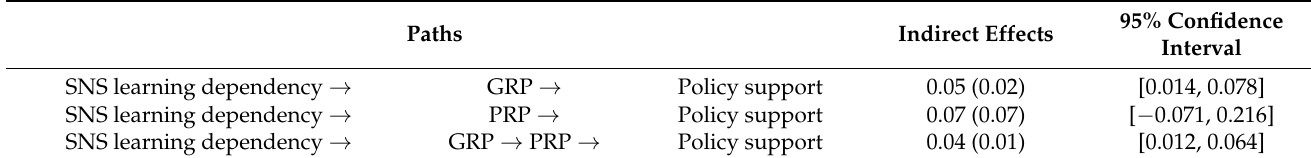
95% Confidence Interval